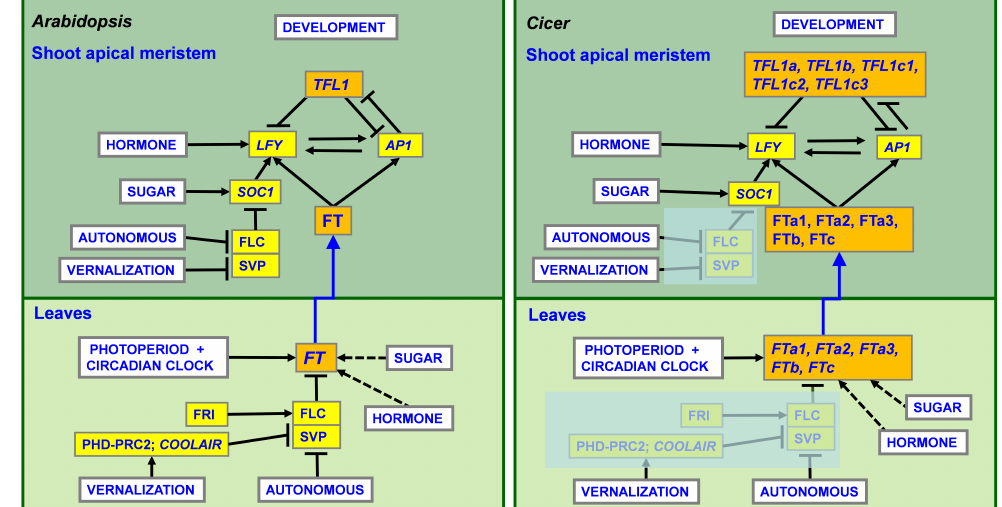
Figure 1. A general overview of the pathways involved in flowering initiation in Arabidopsis ; the presumptive flowering time network in Cicer . FT and TFL1 integrators, which have several copies in the Cicer genome, are highlighted in orange. Dashed arrows correspond to indirect/putative mechanisms (FLOR-ID database, [6]). The vernalization response mechanism via regulation of FLC gene, which is missing in Cicer , is shown in pale colors. The scheme shows only major regulators; for a more detailed description of flowering regulation in Arabidopsis , see